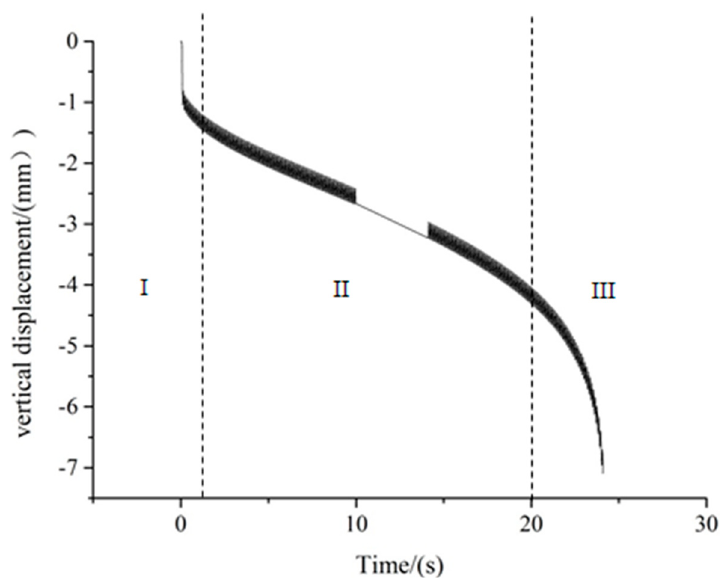
Figure 14. Time-displacement curve of the sample in the laboratory test.